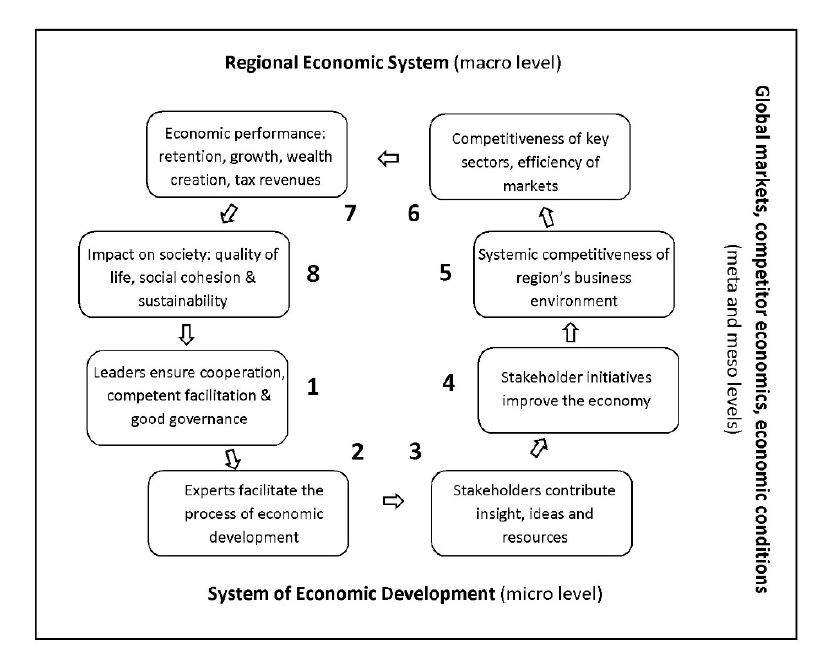
FIGURE 1: Guidelines for LED